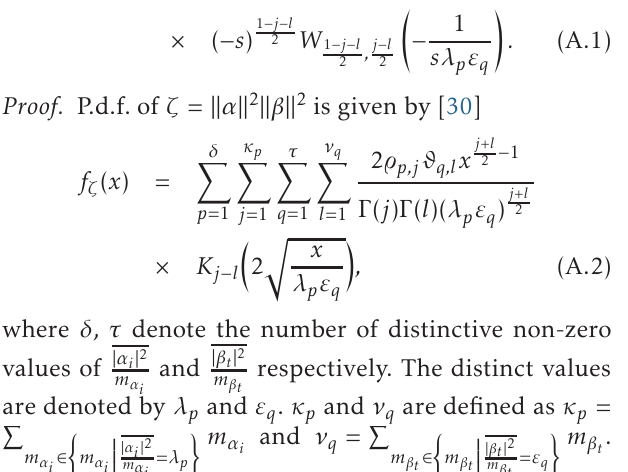
relaying and DF-AF MIMO relaying, the analyti- cal results give lower and upper bounds for the simulation